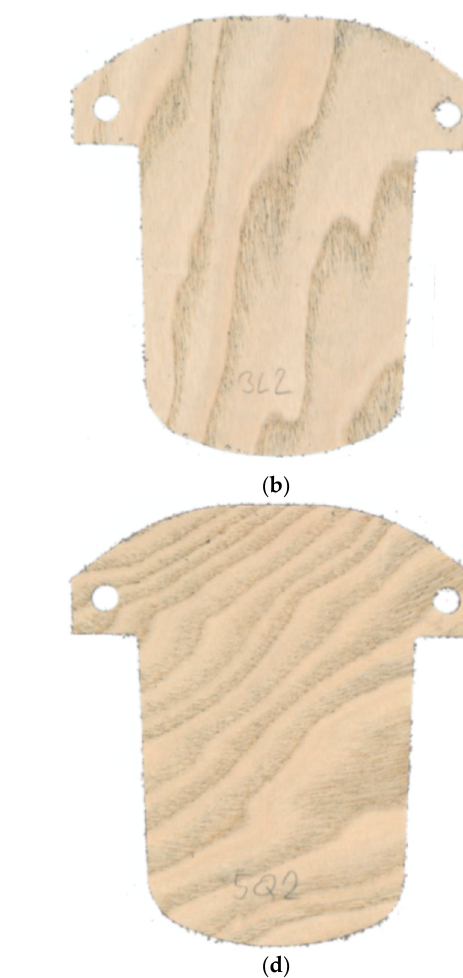
Figure 2. Forming samples of different texturing through the ash wood growth rings with numbers: ( a ) 1 ∥ , ( b ) 2 ∥ , ( c ) 3 ∥ , ( d ) 4 ⊥